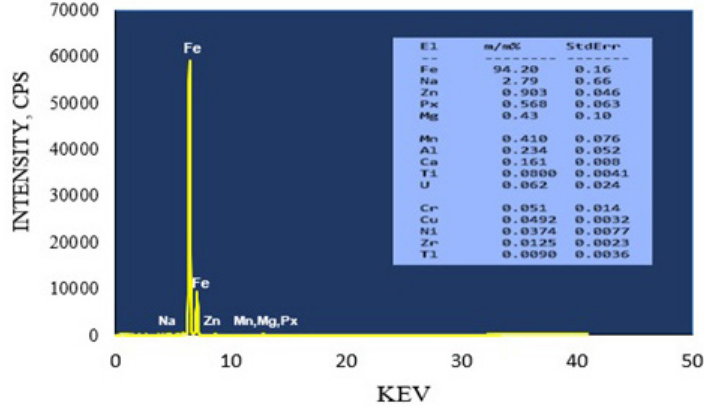
Figure 7. The X-Ray spectrum analysis of elemental composition of the iron powder produced after reduction at 800 0